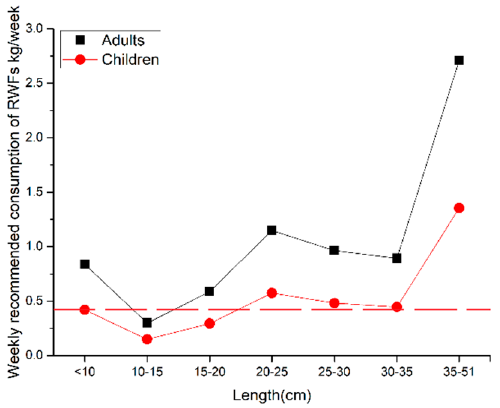
Figure 4. Target hazard quotient (THQ) of Cr and total target hazard quotient (TTHQ) in fish with different length ranges.